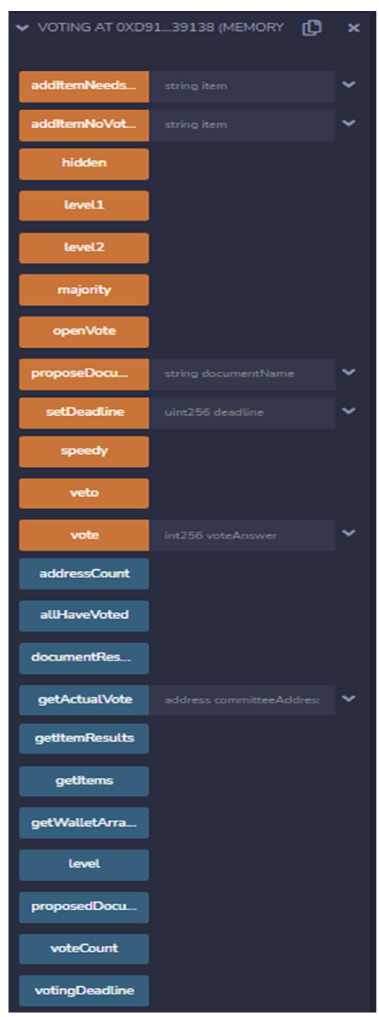
Figure 6. smartMinutes initial deployment output GUI. Figure 6. SmartMinutes initial deployment output GUI.